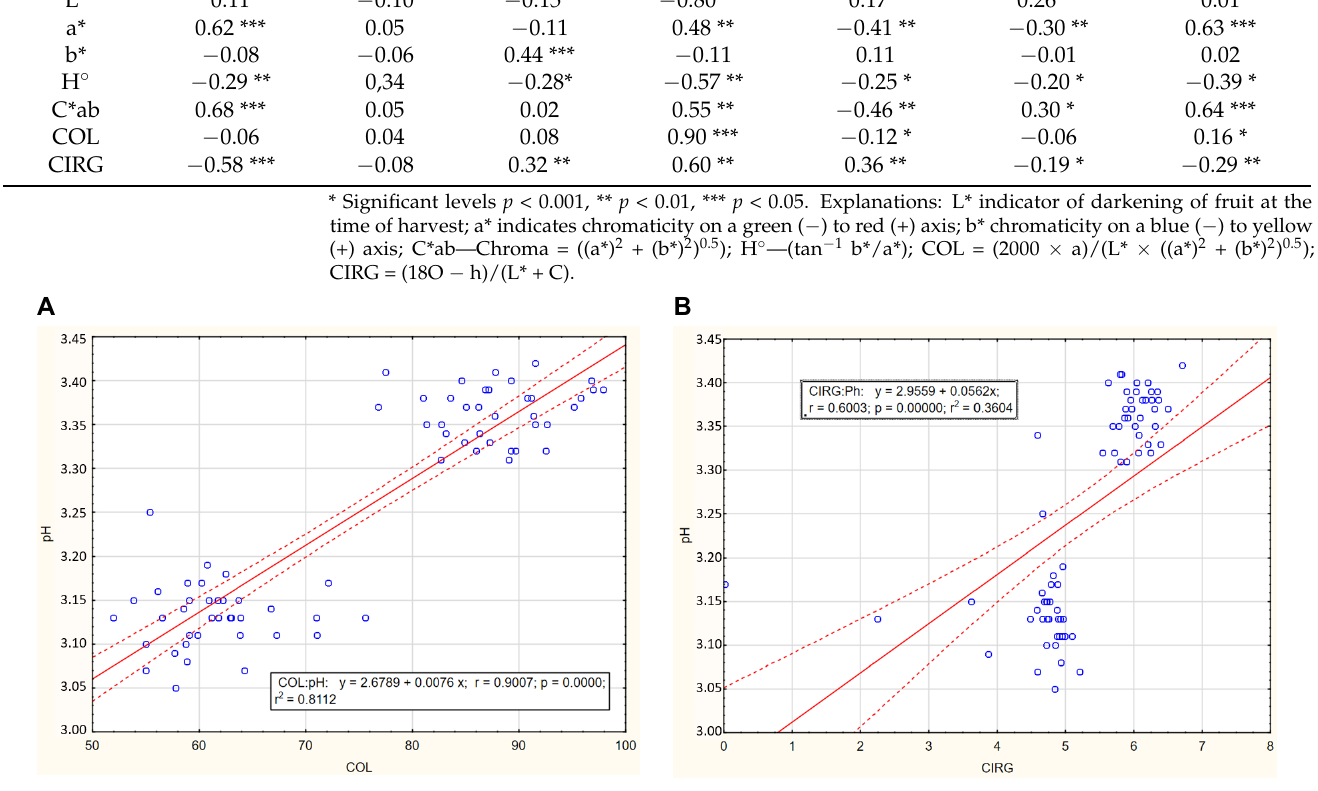
Figure 4. Relationship between pH sour cherry juice and color index for: A (COL) B (CIRG). Table 11. Correlation coefficient between fruit coloring and fruit quality